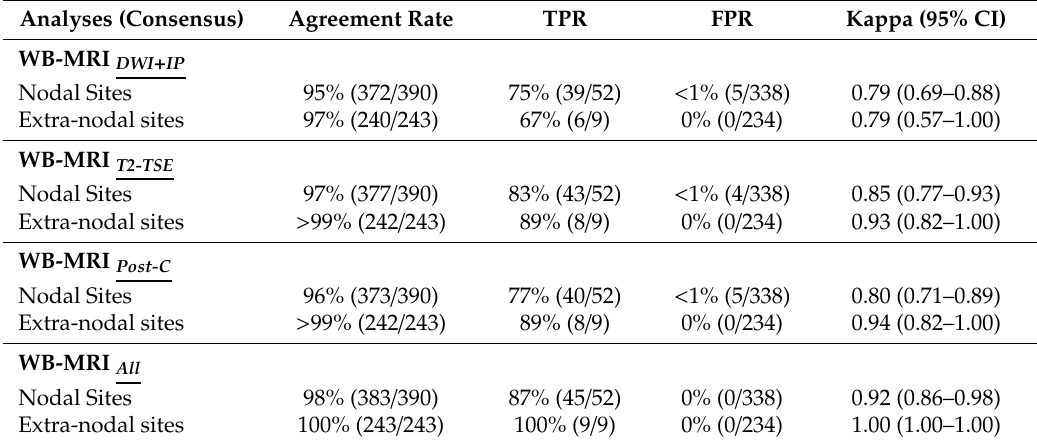
Table 5. Comparison of di ff erent MRI sequences as part of the WB-MRI protocol for nodal and extra-nodal disease evaluation for the consensus